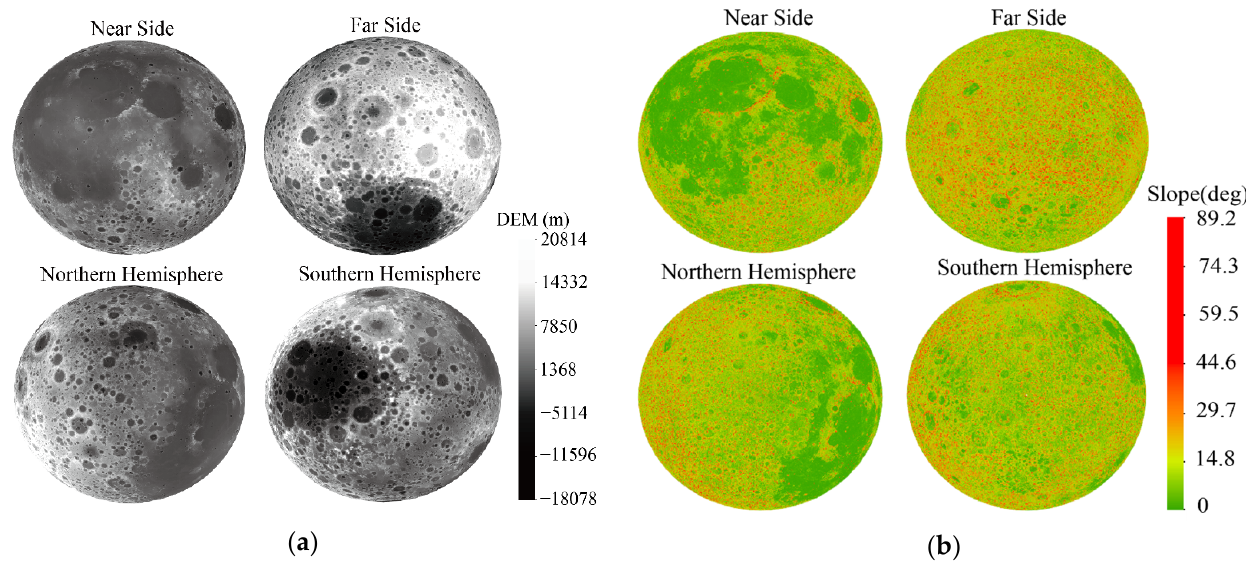
Figure 5. The ( a ) DEM and ( b ) slope of Moon on the near side and far side, and in the northern hemisphere and southern hemisphere, respectively (The figure was created by ArcGIS, Matlab, etc.).